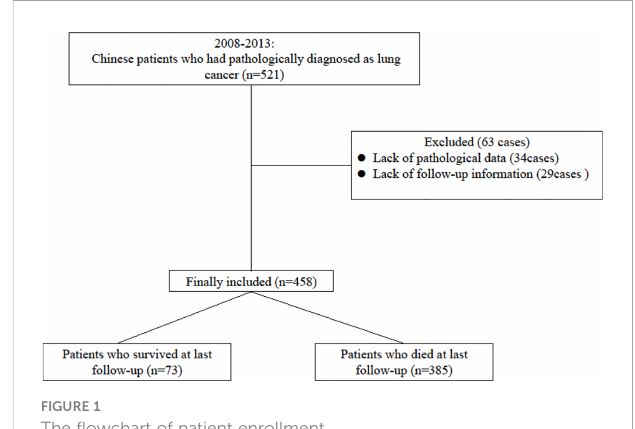
FIGURE 1 The fl owchart of patient